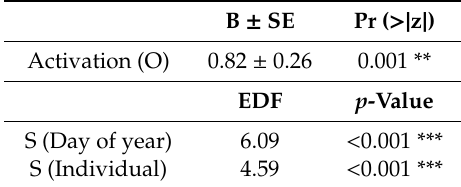
Table 2. Summary table of the best model for the daily number of visits to feeding sites. For the fixed effects, we reported beta coefficients, and relative standard errors ( β ± SE), while for the splines we reported the estimated degrees of freedom (EDF). Legend: Activation (O) = active feeding site, reference category = closed feeding site; S (Day of year) = spline of the day of the year; S (Individual) = spline of the random effect of the individual; ** = 0.001 < p < 0.01; *** = p < 0.001